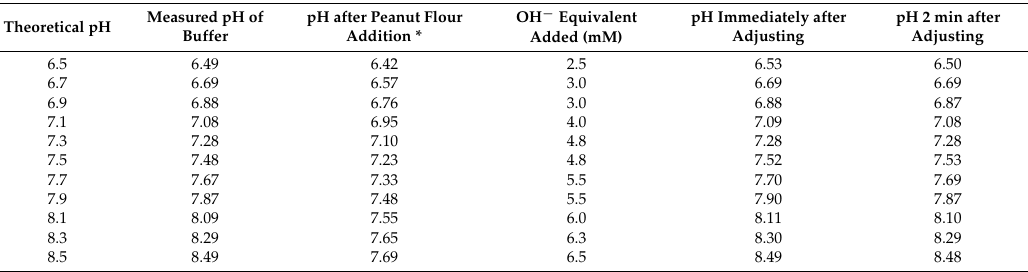
Table 1. Influence of peanut flour dissolution on the pH of the extraction buffer.